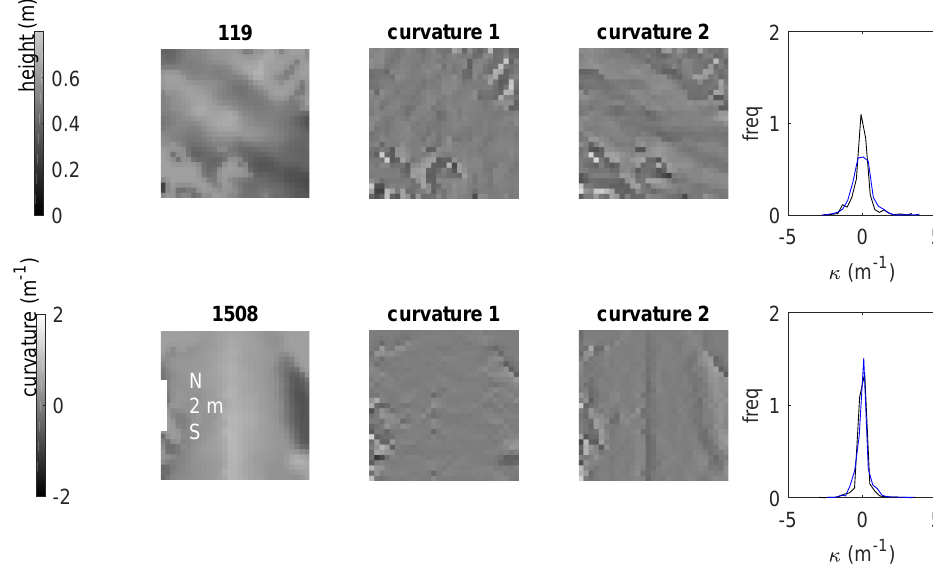
Figure 7. Top , from left to right: The height map of a 5.3-m square spot with two parallel ruts, the direction with the smoothest curvature, the direction with the most drastic curvature distribution and the corresponding histograms f 1 and f 2 . Bottom : A spot with a ditch beside a road having a sharp V shape. beside a road having a sharp V shape. The curvature is rather isotropic. Actual samples are circular and centered on squares depicted with a radius r =